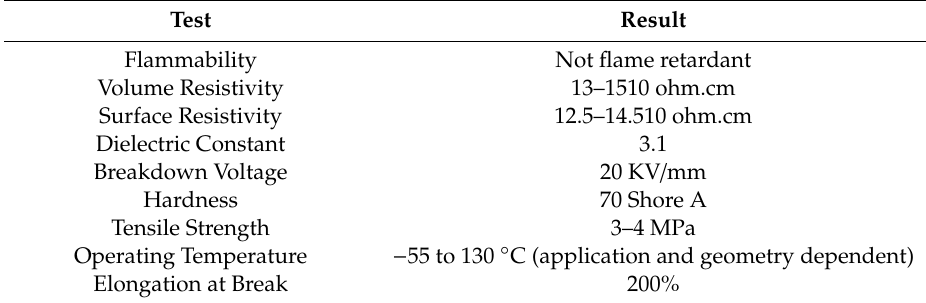
Table 1. Material properties of polyurethane used for marinization of the